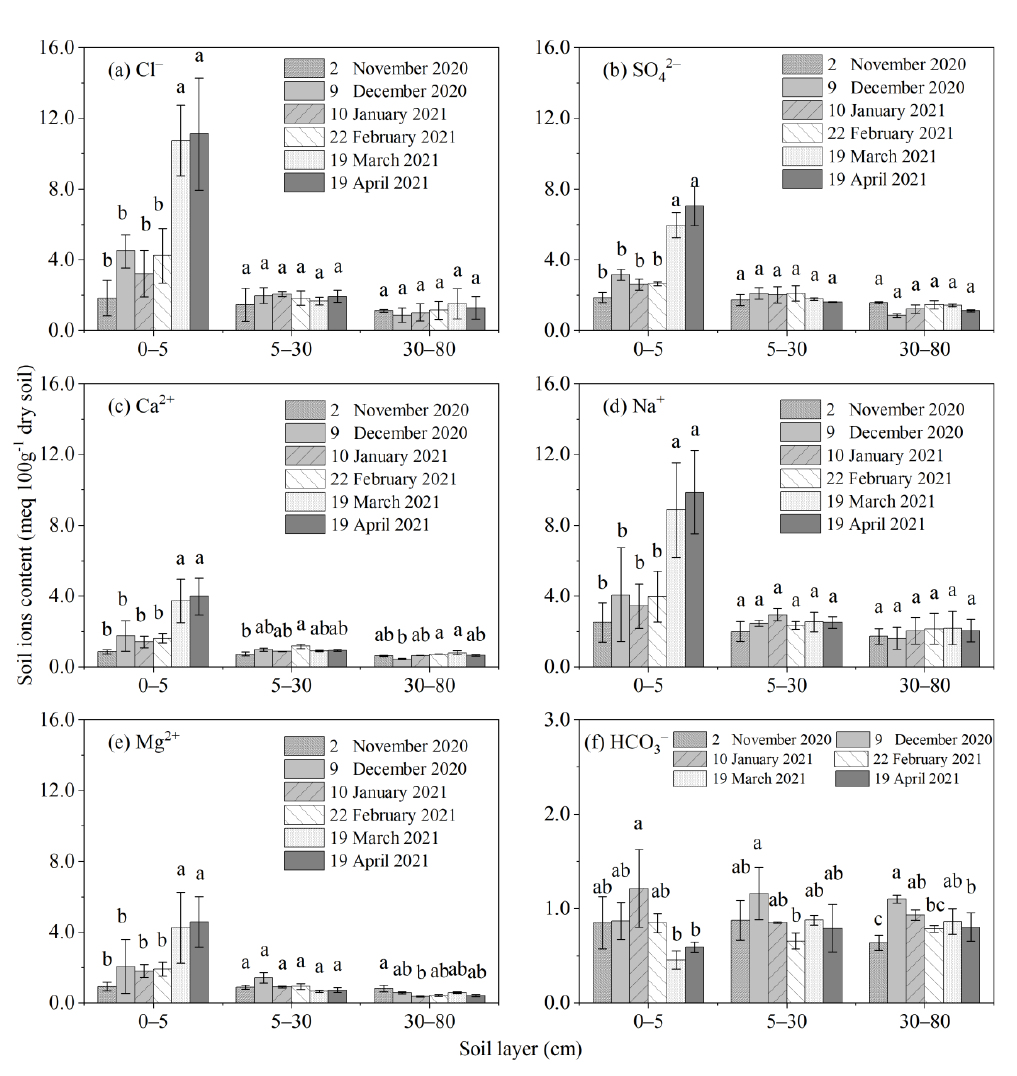
Figure 5. Changes in the soil soluble ion concentrations during the freeze – thaw process: ( a ) Cl – ; ( b ) SO 42 – ; ( c ) Ca 2+ ; ( d ) Na + ; ( e ) Mg 2+ ; ( f ) HCO 3 – . Note: Different lowercase letters indicate significant differences between different times ( p < 0.05). The vertical line represents the S.D. of the average.